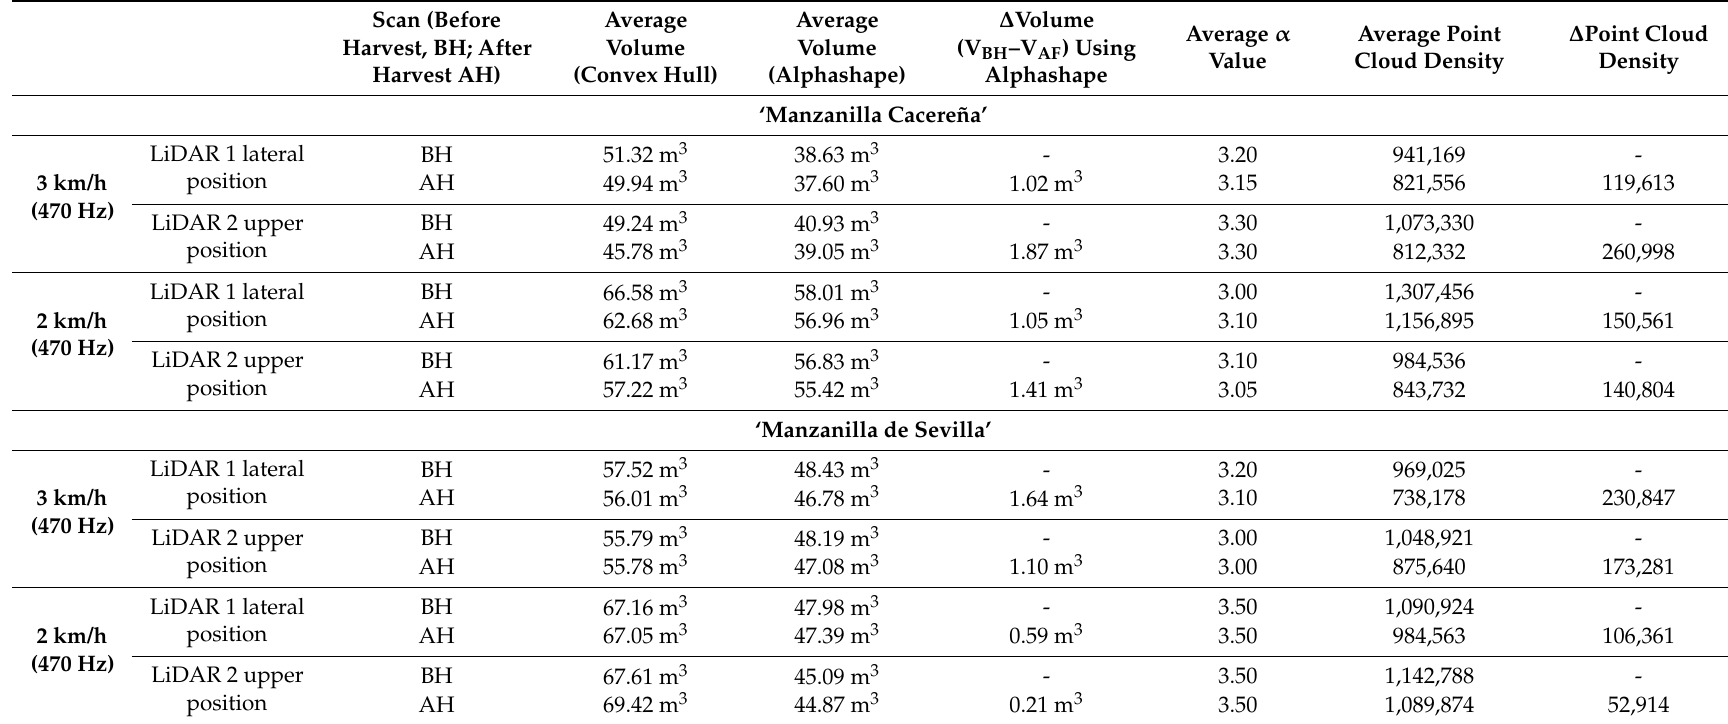
Table 5. Tree row volume scanned with LiDAR